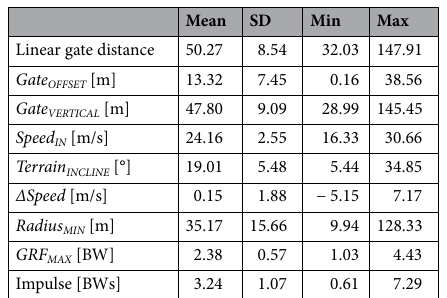
Table 1. Mean, SD, and minimal and maximal values for predictors and outcome variables of the mixed model for Super-G.